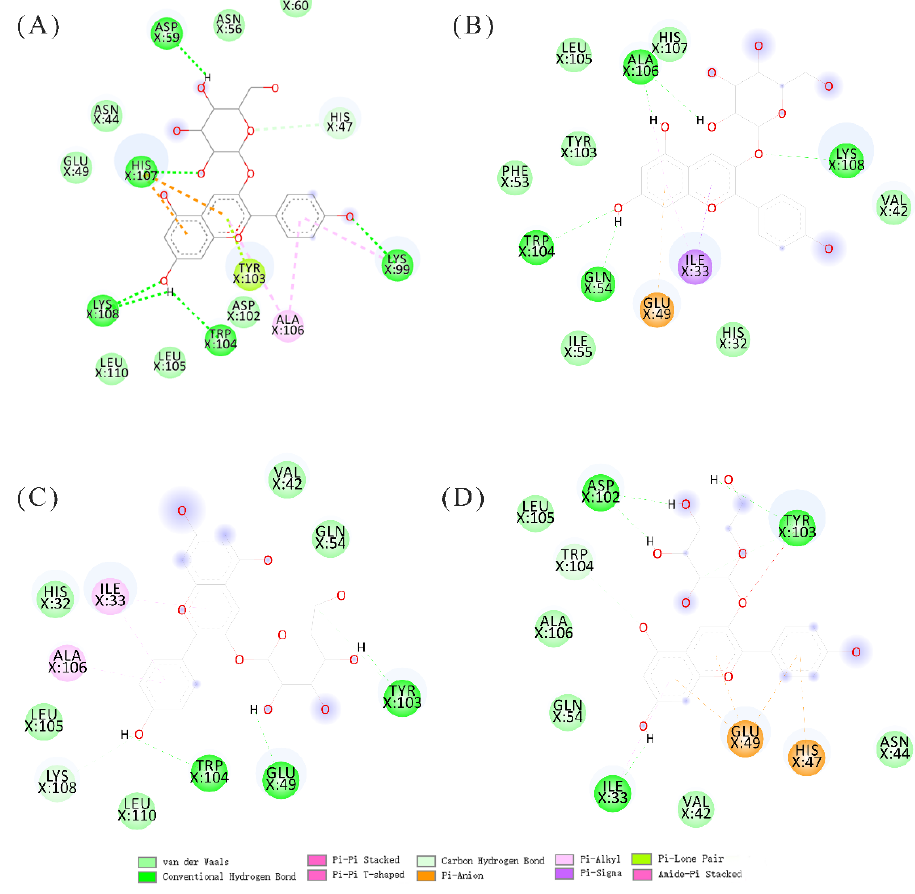
Figure 4. Molecular docking results of α-Lactalbumin and pelargonium-3-glucoside at different thermal treatments. ( A – D ): The interactions between residues of α-Lactalbumin and pelargonium- thermal treatments. ( A – D ): The interactions between residues of α -Lactalbumin and pelargonium-3- 3-glucoside at 20 °C, 40 °C, 60 °C, and 80 °C, respectively. glucoside at 20 ◦ C, 40 ◦ C, 60 ◦ C, and 80 ◦ C,